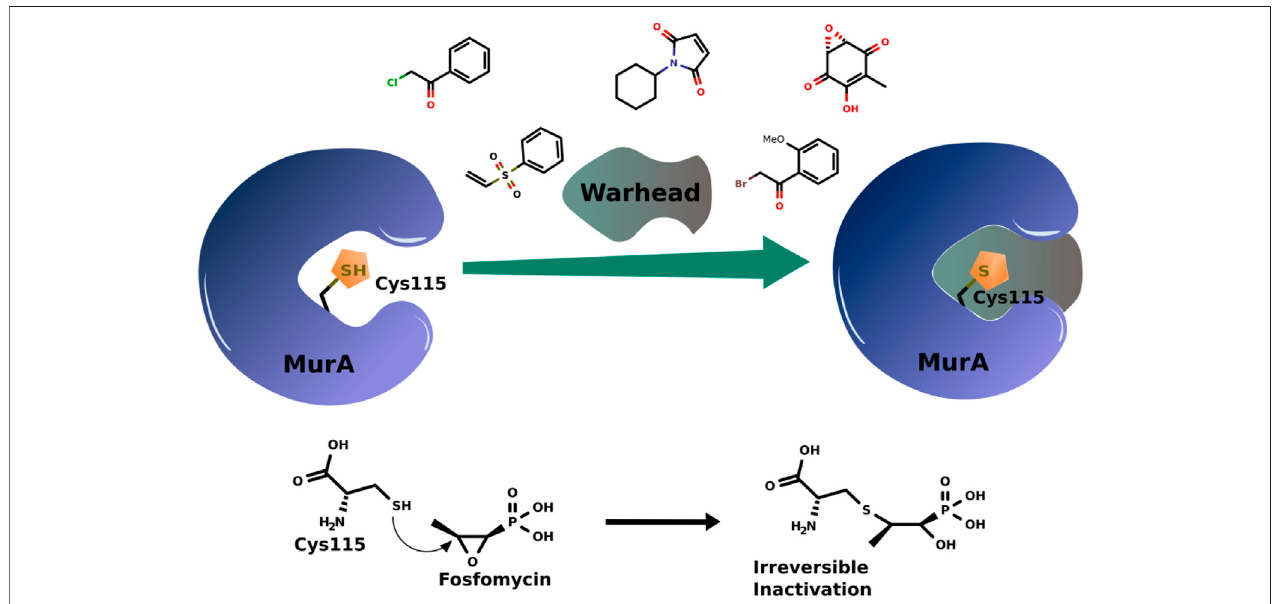
FIGURE 2 | Scheme of covalent bond formation in MurA with some examples of warhead covalent inhibitors and the action mechanism of fosfomycin.